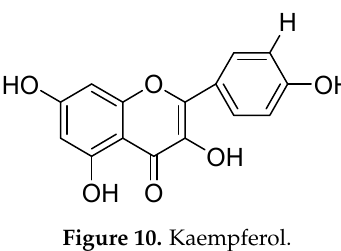
Figure 10. Kaempferol.